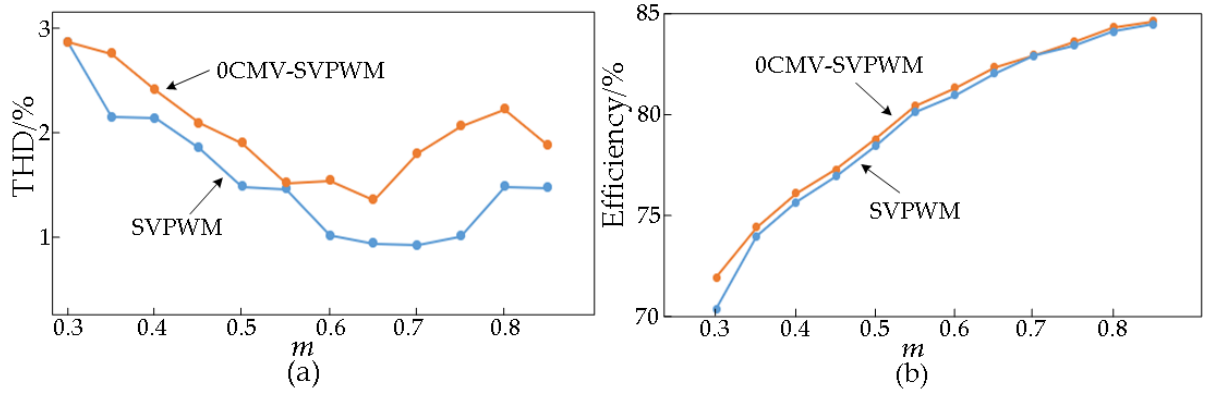
Figure 15. Output characteristics under different modulation index: ( a ) THD of output current ( b ) Output efficiency.